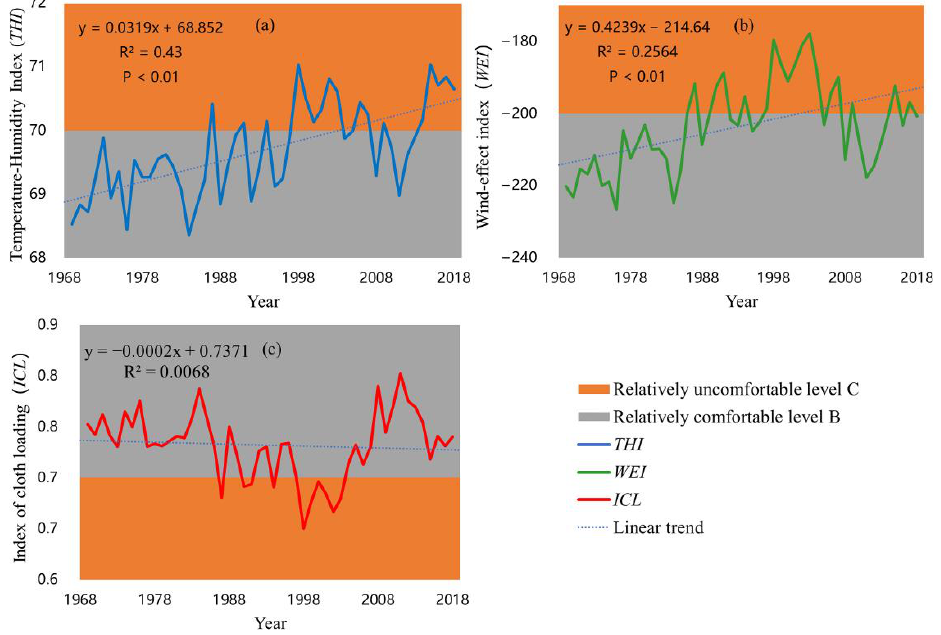
Figure 2. Interannual variations of comfort index from 1969 to 2018. ( a ): THI , ( b ): WEI , ( c ): ICL . The variation of averaged monthly uncomfortable periods in the last 50 years was given in Figure 3. In terms of heat and humidity, the non-comfort period ( 70 ≤ THI ≤ 80 ) in Guangdong lasts from May to October, which is associated with the combination of